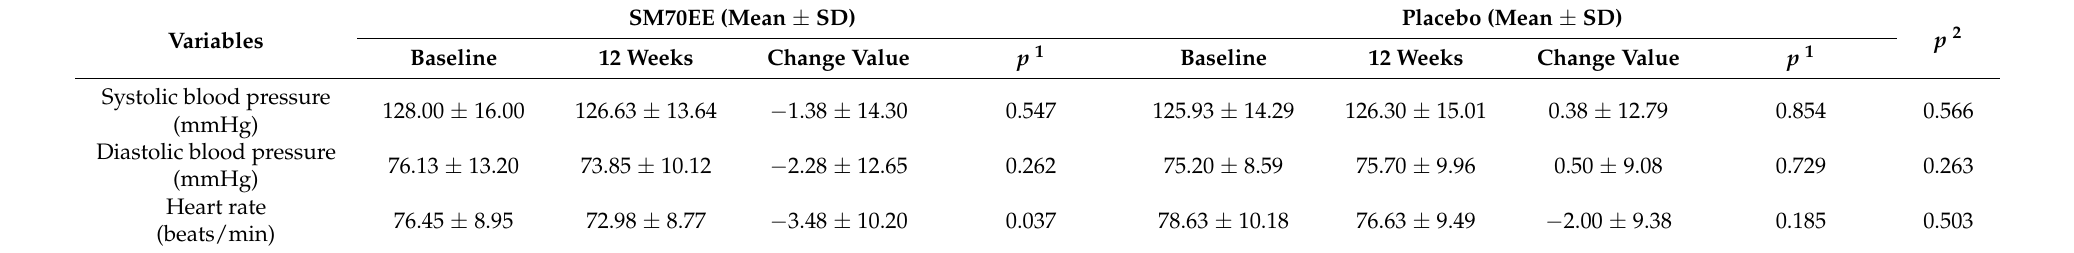
Table 8. Changes in test results concerning vital signs before and after 12 weeks of SM70EE product consumption.